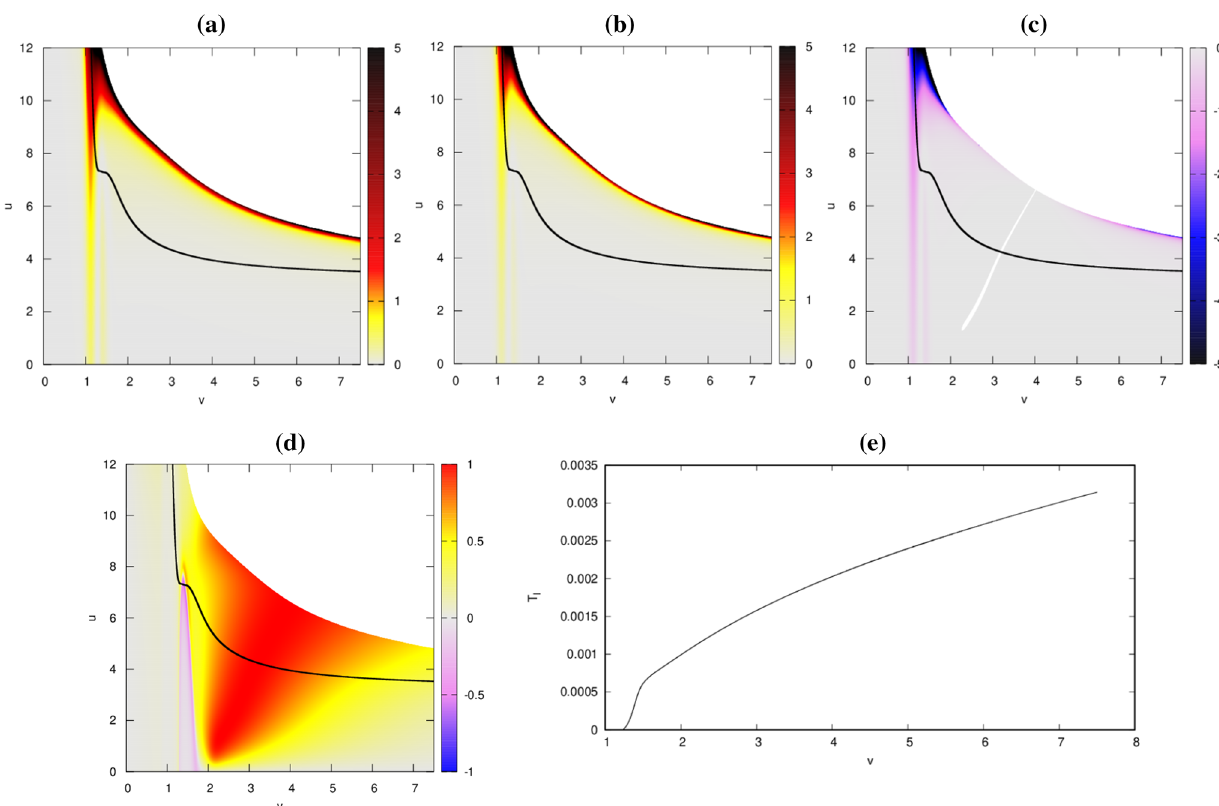
Fig. 11 The (v u ) -distribution of a energy density, ˆ ρ , b radial pressure, ˆ p ˆ p r , c pressure anisotropy, a , d tangential to radial pressures ratio, and e local temperature along the black hole apparent horizon, T l , as